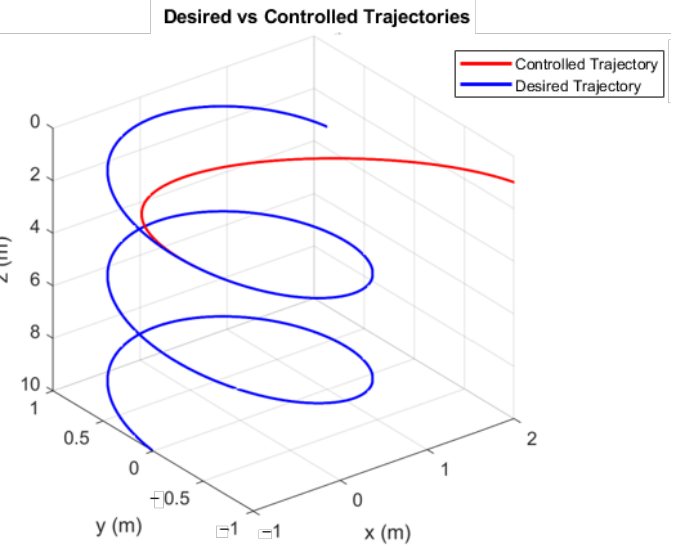
Figure 12. Simulated three-dimensional trajectory of the BlueROV2 when subject to ocean currents and t b = 5 s.